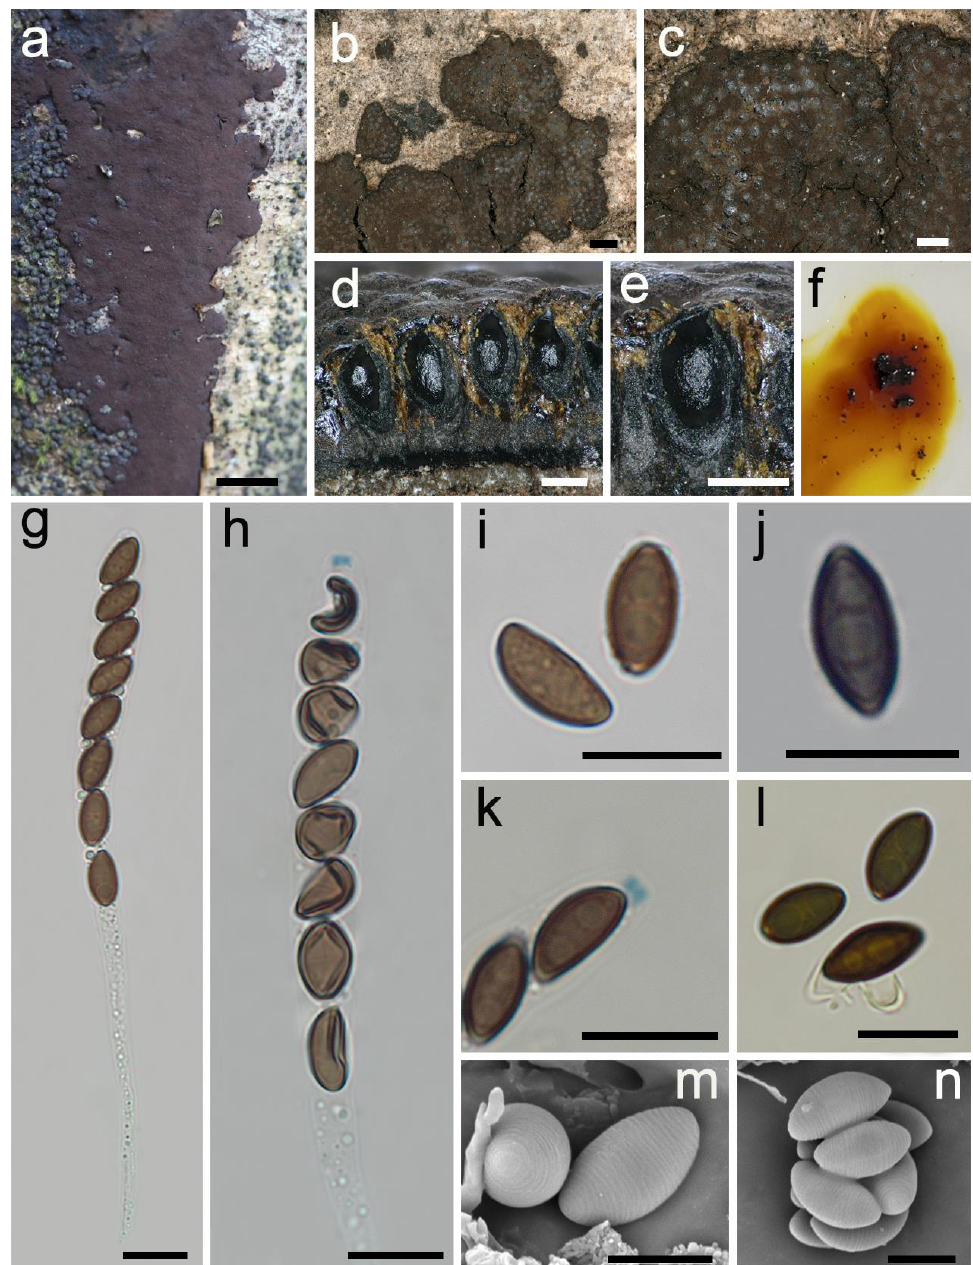
Figure 2. Hypoxylon damuense (holotype FCATAS 4207). ( a , b ) Stromata on the bark of dead wood. ( c ) Stromatal surface. ( d , e ) Stroma in vertical section showing perithecia and ostioles. ( f ) KOH- extractable pigments. ( g ) Asci in water. ( h ) Asci in Melzer’s reagent. ( i ) Ascospores in water. ( j ) Ascospore in 10% KOH showing germ slit. ( k ) Apical apparatus in Melzer’s reagent. ( l ) Ascospores in 10% KOH. ( m , n ) Ascospores under SEM. Scale bars: ( a ) = 1 cm; ( b ) = 1000 µ m; ( c ) = 500 µ m; ( d , e ) = 200 µ m; ( g – l ) = 10 µ m; ( m , n ) = 5 µ m. Hypoxylon medogense Hai X. Ma, Z.K. Song and Y. Li, sp. nov., Figure